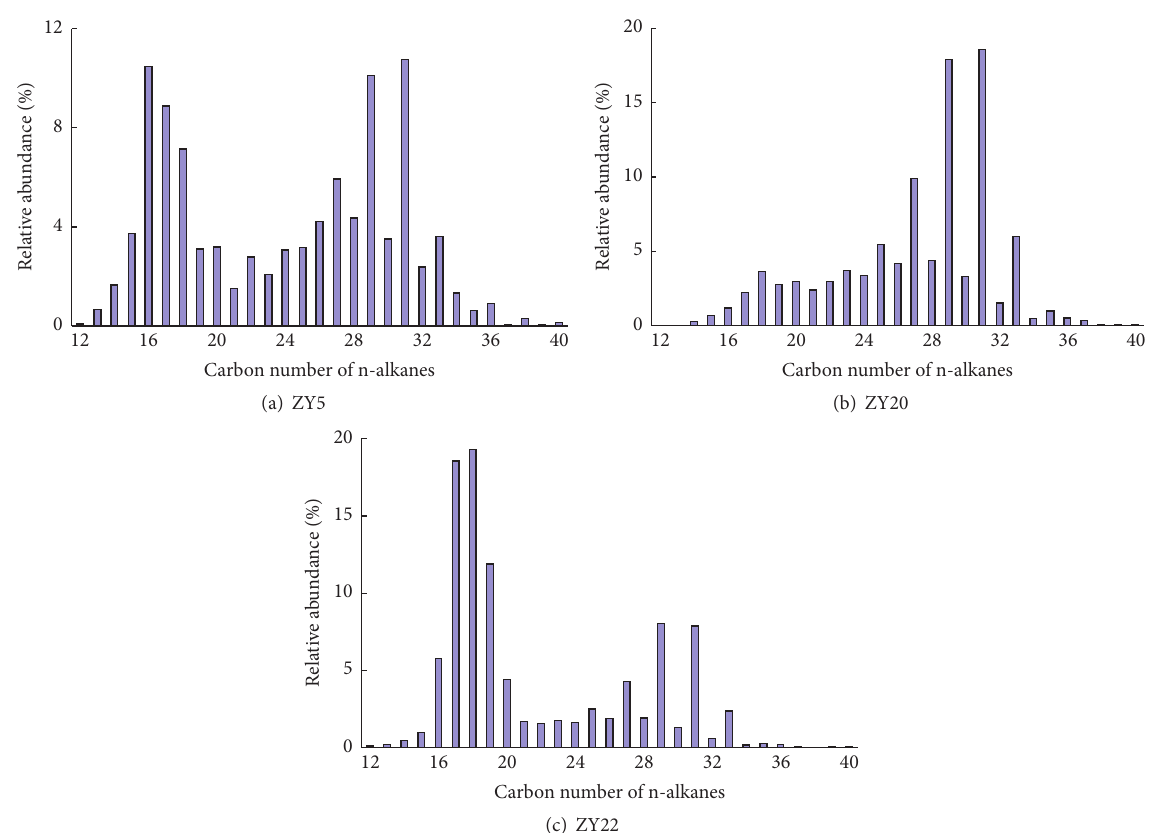
Figure 3: The three typical distribution patterns of n-alkane contents. ((a) Terrestrial and marine input; (b) stronger terrestrial input; (c) weaker terrestrial